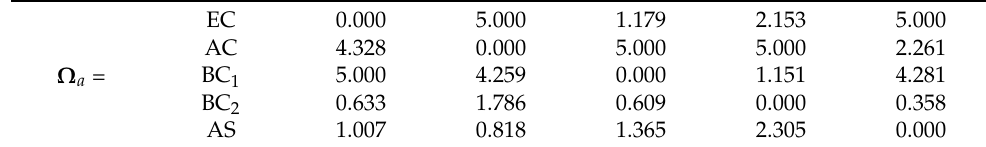
Table 6. IRM Ω a .